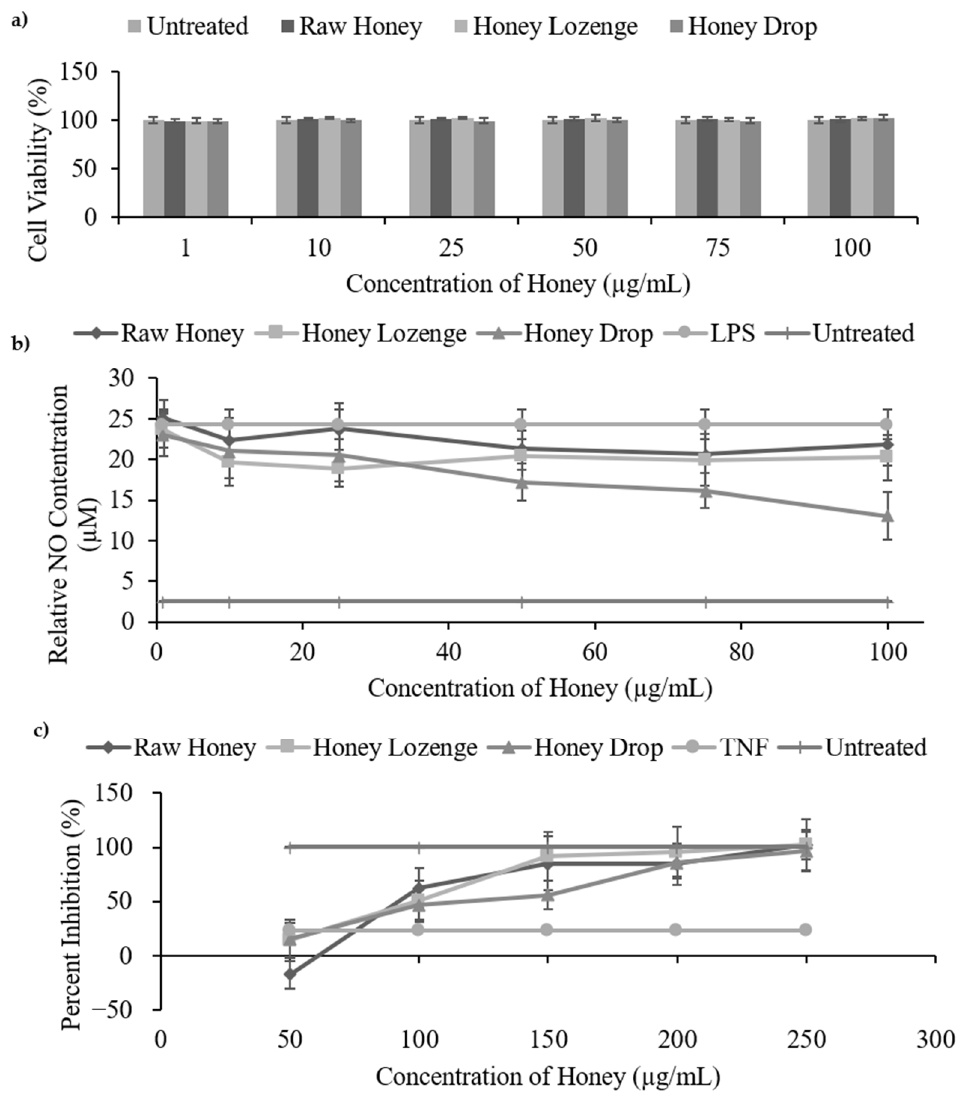
Figure 4. In vitro anti-inflammatory assays of honey samples. ( a ) Cell viability of Raw 264.7 macrophages treated with honey samples (1–100 µ g/mL in PBS). ( b ) Nitric oxide inhibition assay measures the ability of the honey samples (1–100 µ g/mL in PBS) to inhibit the production of nitric oxide by Raw 264.7 macrophages that were stimulated by LPS (1 µ g/mL). ( c ) TNF- α cytotoxicity assay. The minimum nitric oxide production for the raw honey, honey lozenge, and honey drop were 20.70 µ M, 19.96 µ M, and 13.02 µ M, respectively, compared with the LPS sample which produced 24.30 µ M of NO and the untreated sample which produced only 2.55 µ M of NO. These values represent a maximum percent inhibition of 14.82% for raw honey, 22.29% for the honey lozenge, and 46.40% for the honey drop. Kassim et al. reported a maximum nitric oxide inhibition of ~16 µ M (~80%) for honey ethyl acetate extracts and ~5.5 µ M (~40%) for honey methanol extracts at concentrations ranging from 3.125–100 µ g/mL [2]. Biluca et al. reported percent nitric oxide inhibition from 25.8% to 37.7% for stingless bee honey from Brazil at concentrations of 10–100 μ g/mL [32].